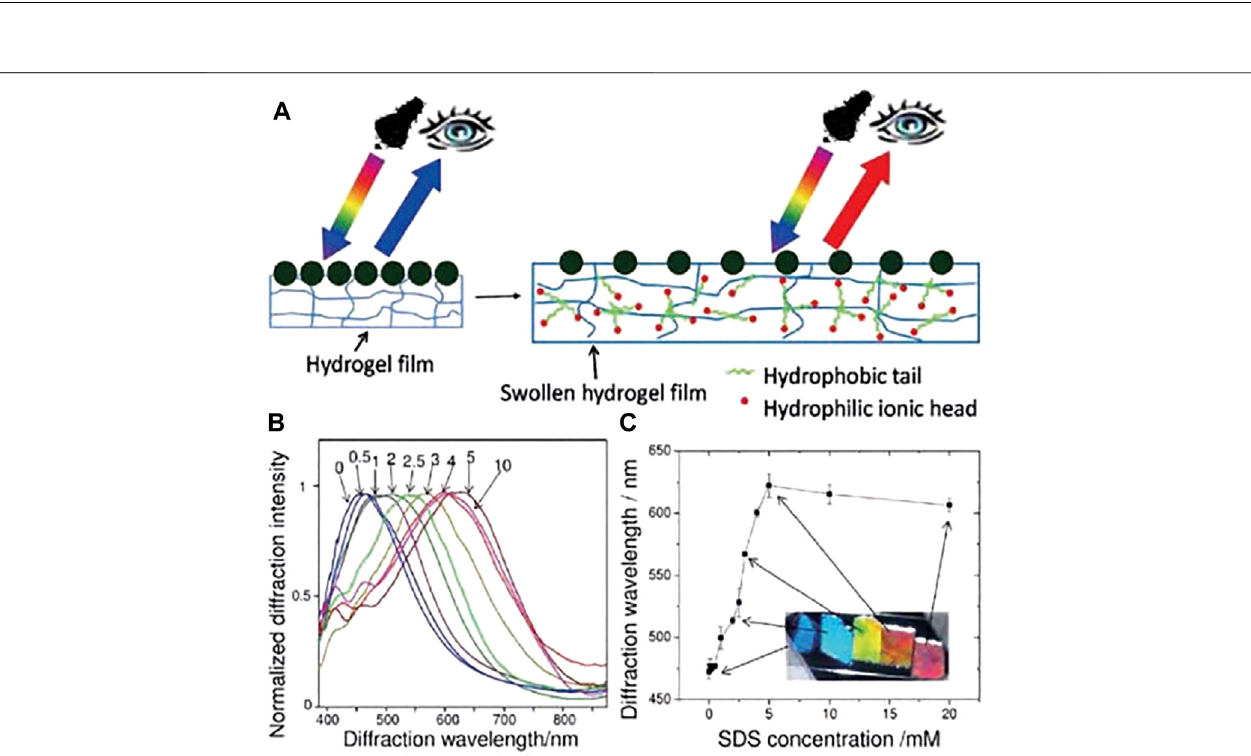
Frontiers in Chemistry |